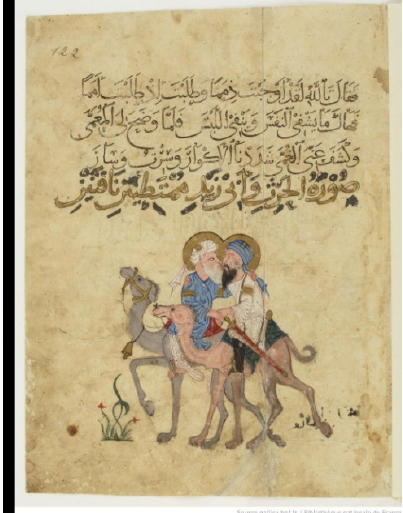
Figure 4. Illustration from the 13th century manuscript Arabe 3929; an assembly of stories in a poetic form, known as the Maqamat by Al-Hariri (1054–1122) of Basra (southern Iraq), produced under the late Abbasid caliphate. The manuscript features 99 surviving miniatures highly esteemed, in mod- ern times, for their authentic depiction of the 13th-century Muslim life. In this image, Abu Zayd and al-Harith are riding their camels while holding each other by the shoulder and hand, face to face or, perhaps more accurately, mouth. There appears to be a heart-shaped figure around their heads.